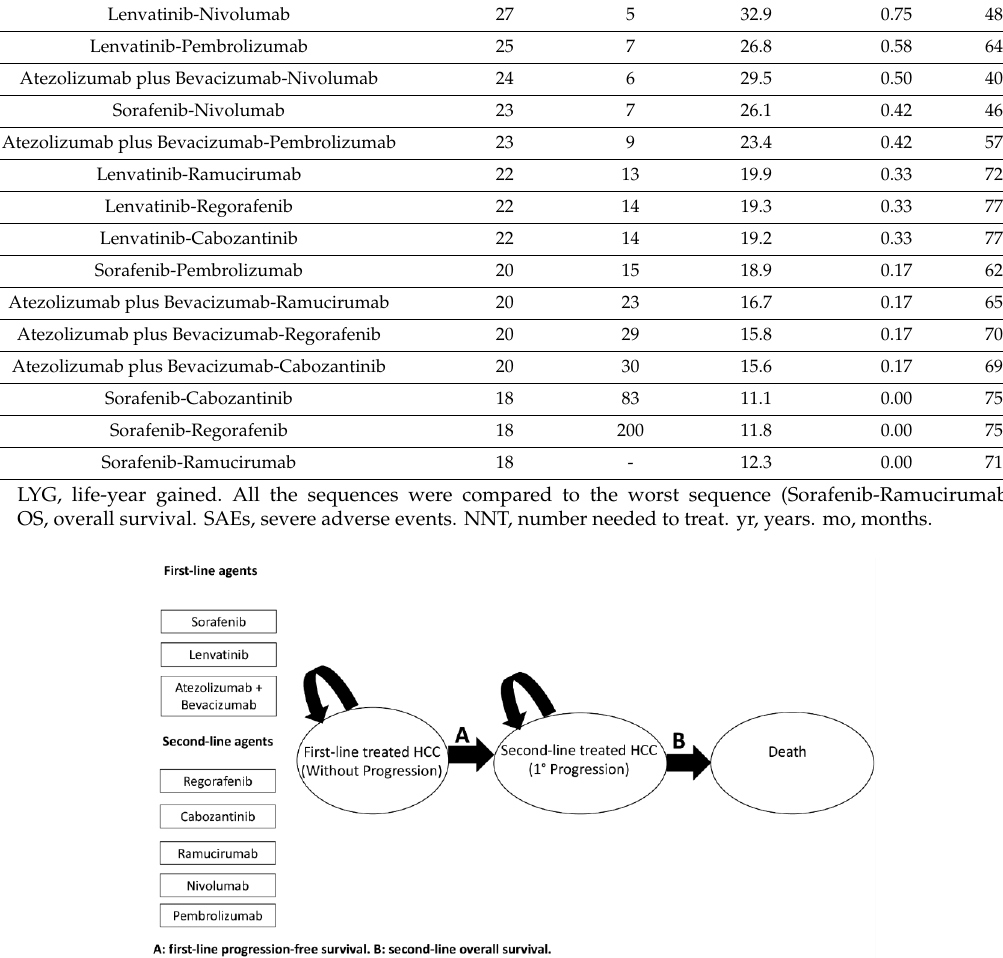
Table 2. Base-case effectiveness and safety of 15 treatment sequences according to median OS. Treatment Sequence